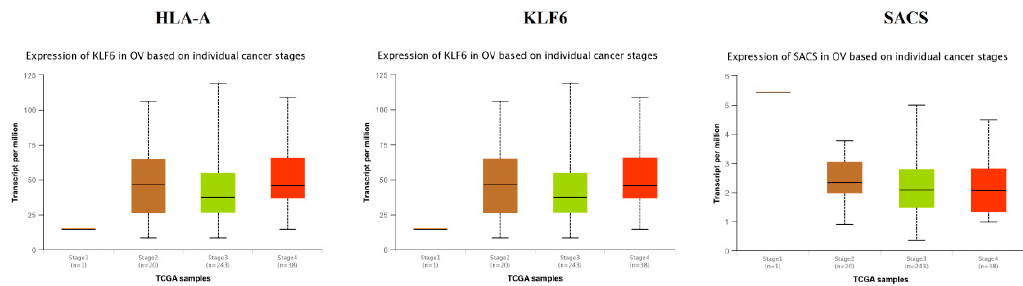
Figure 17. Validation of the expression of hub genes in the TCGA database. High expression of hub genes in stages 2 and 4.